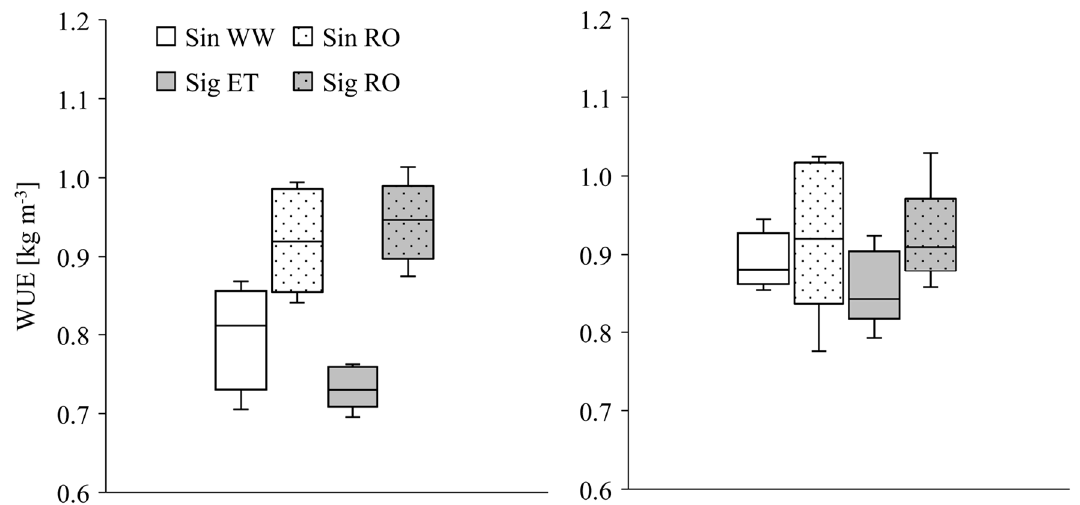
Figure 3. Water use efficiency (WUE) of soybean in unlimited (WW) and water stress (RO) conditions in pooled dry (2017 and 2019) and wet (2018 and 2020) growing seasons. The two soybean varieties used were Sinara, Sin and Sigalia, Sig.